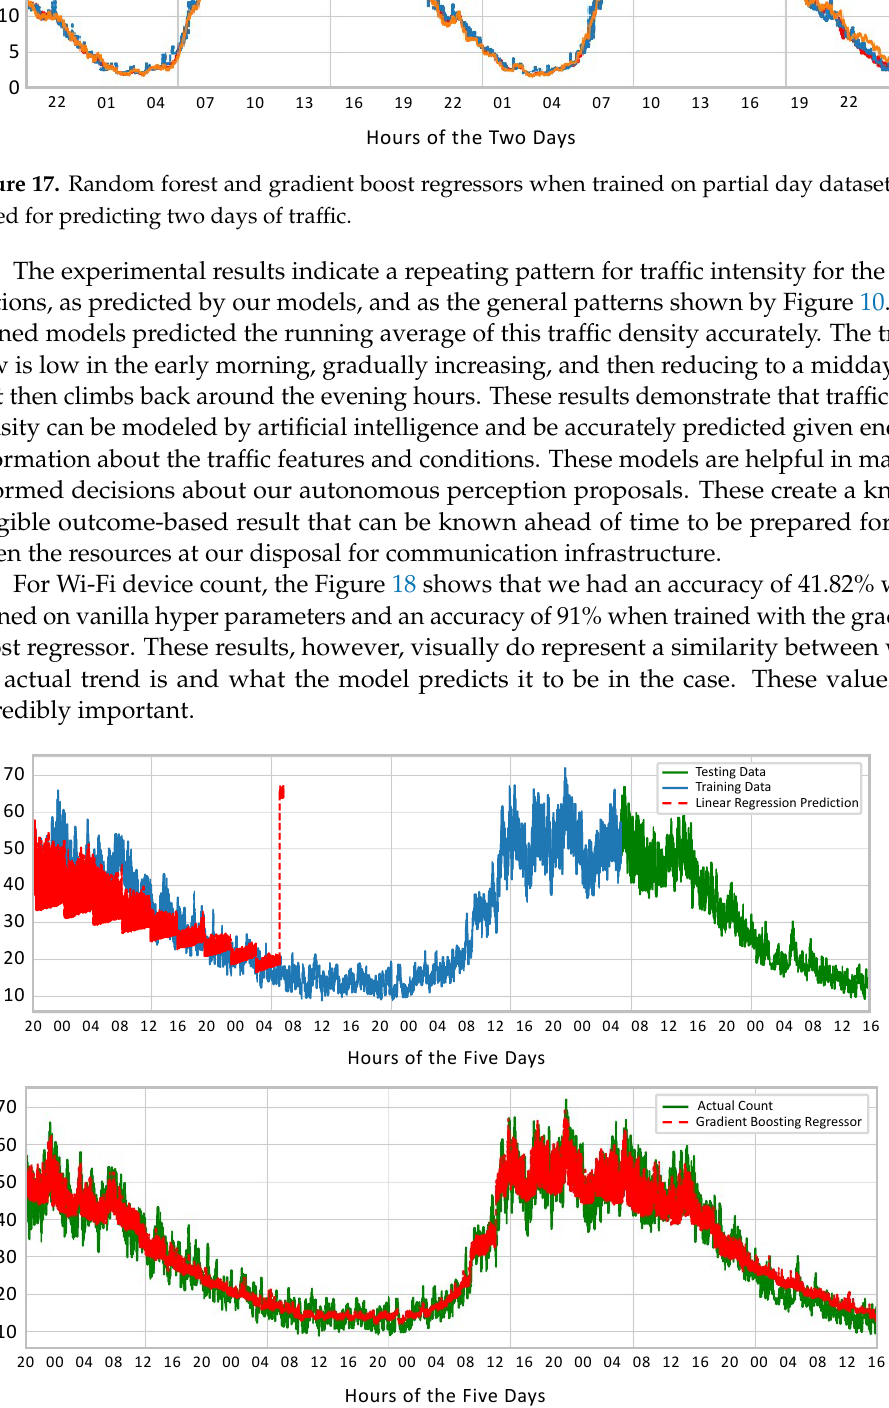
Figure 18. WiFi devices’ prediction. Gradient boost model predictions for five days ( Upper ). The training dataset with prediction based on XGBoost model ( Lower